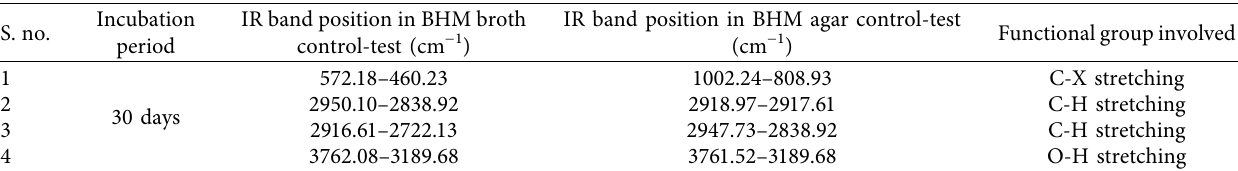
Table 5: Comparison of IR band position in the PP films after incubation with Pseudomonas sp. in BHM broth and BHM agar (both control and